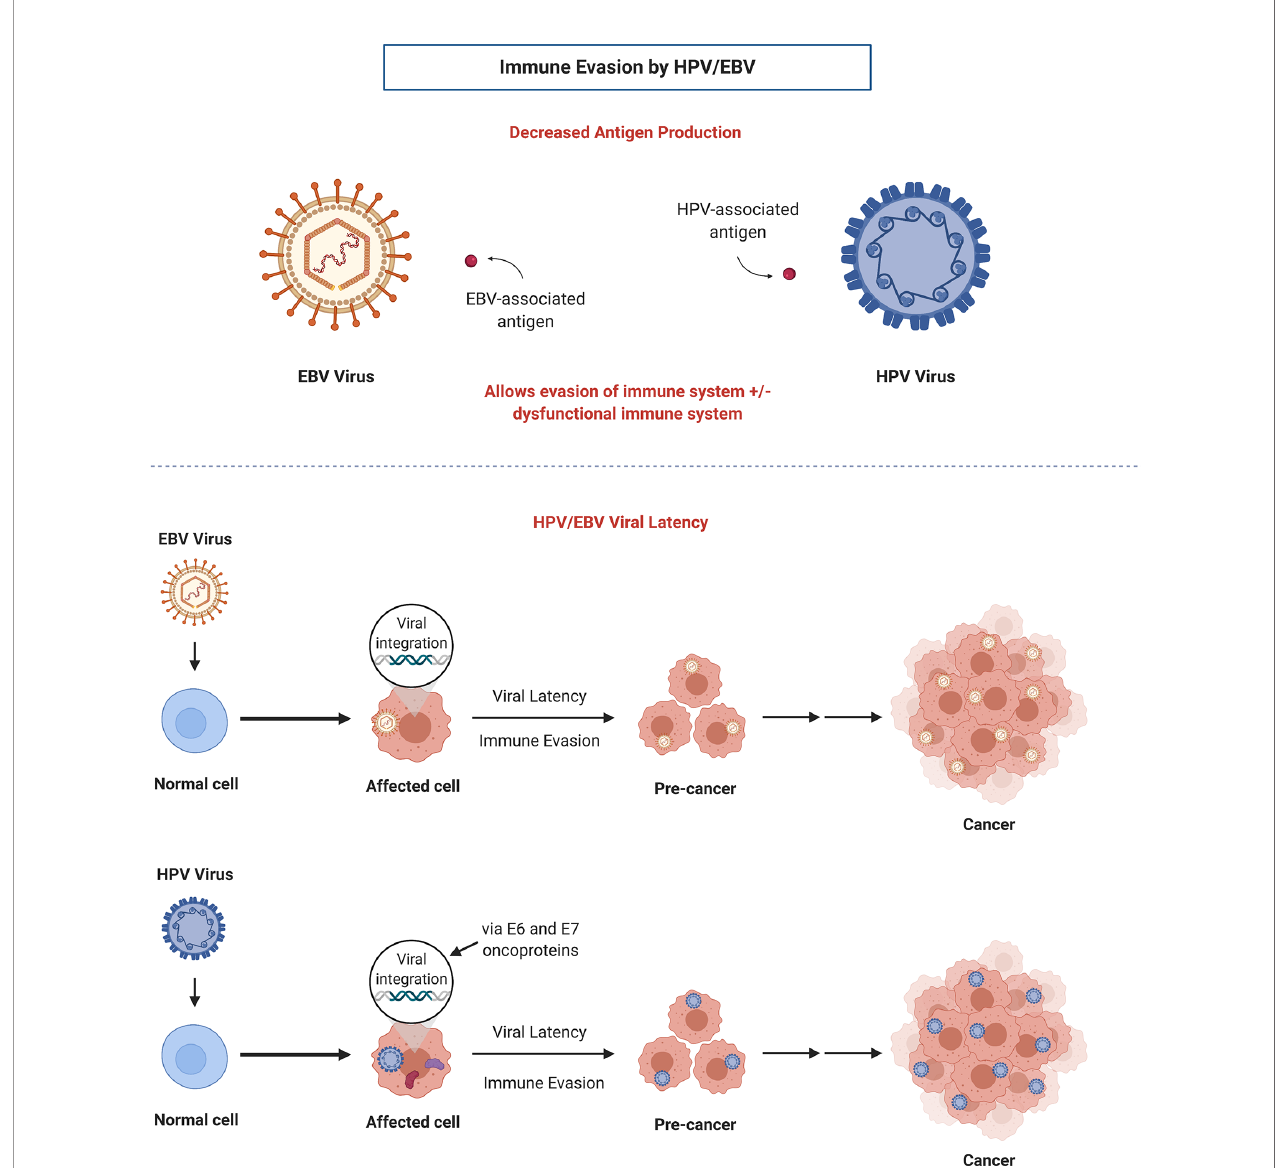
FIGURE 1 | Mechanisms of immune evasion by HPV and EBV: decreased antigen production and establishment of viral latency. Adapted from “ Viral Carcinogenesis ” , by BioRender.com (2021). Retrieved from